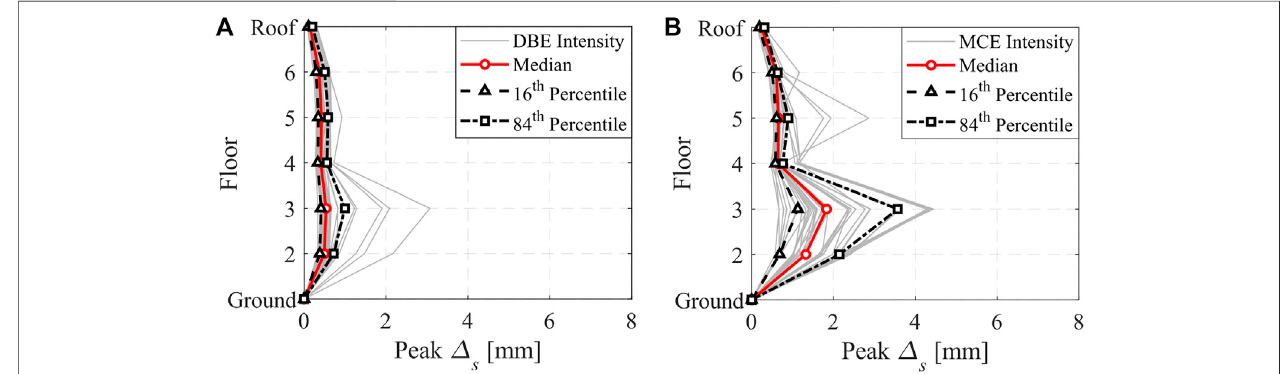
Frontiers in Built Environment |